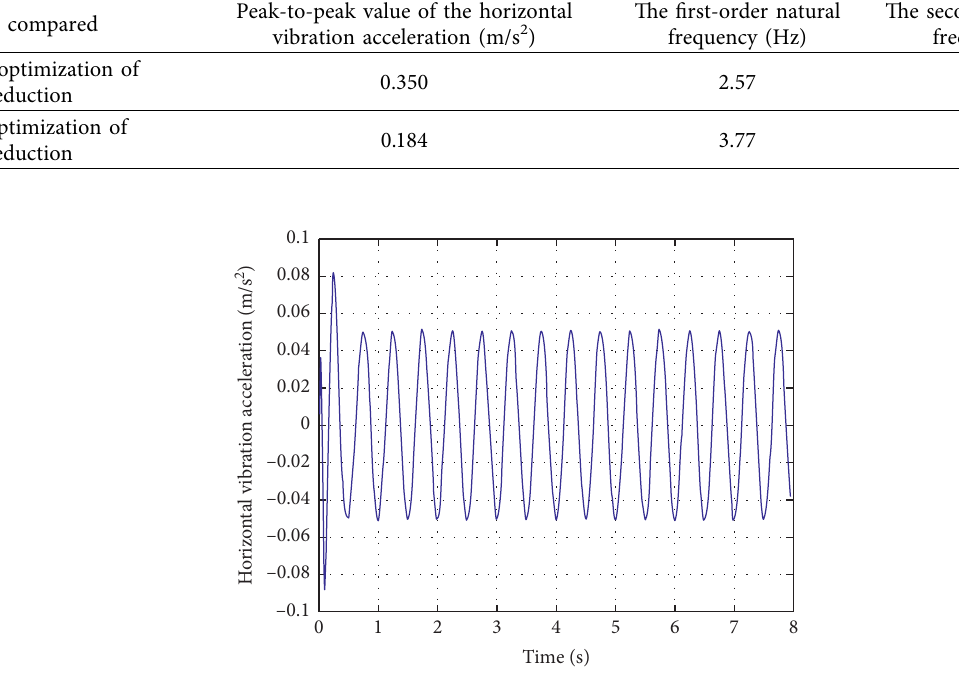
Figure 14: Horizontal vibration response curve after vibration reduction